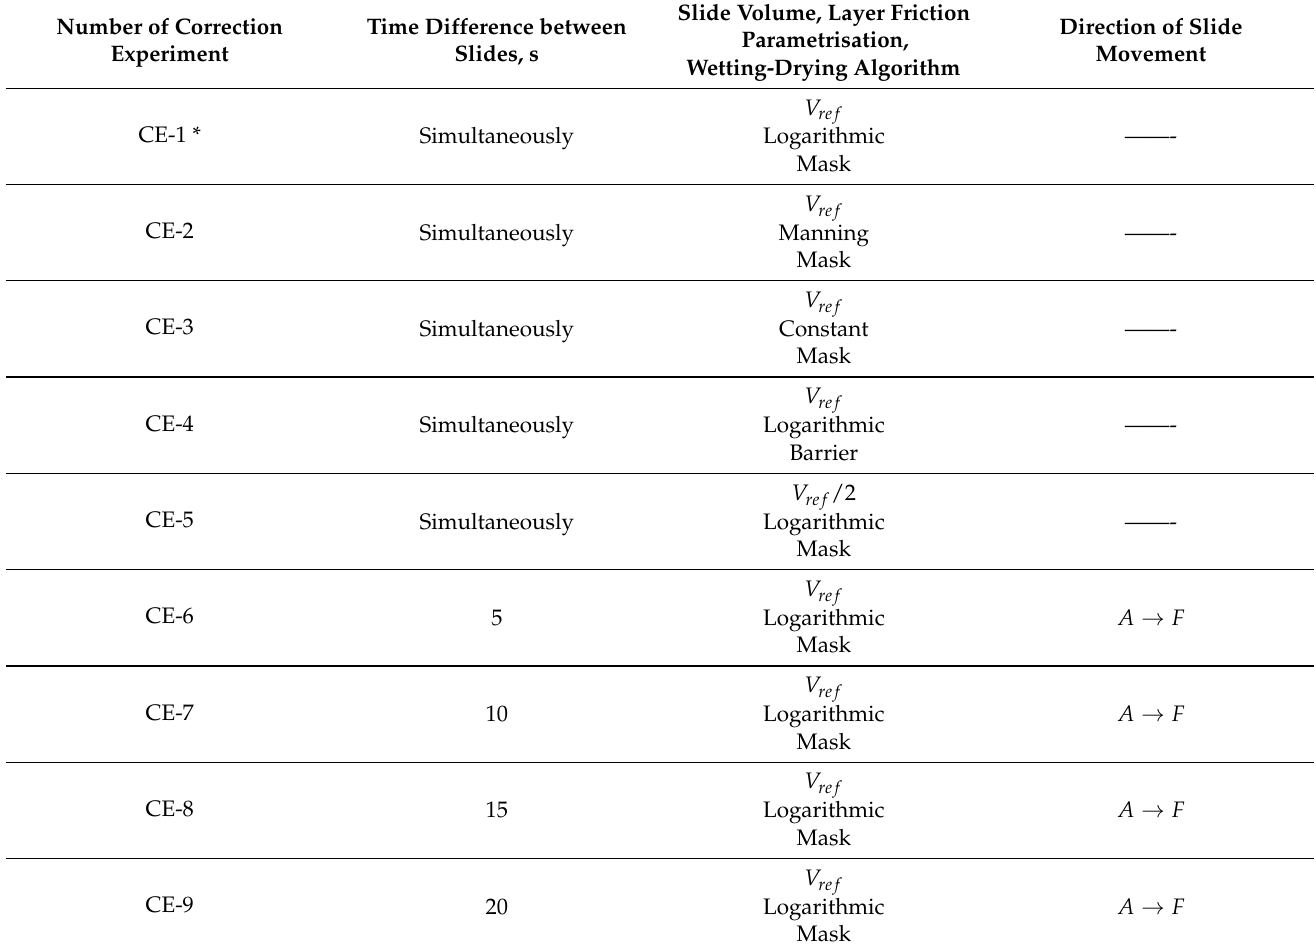
Table 3. Summary of characteristic quantities of the correction experiments (CE). The slide density is 2.4 t/m 3 .